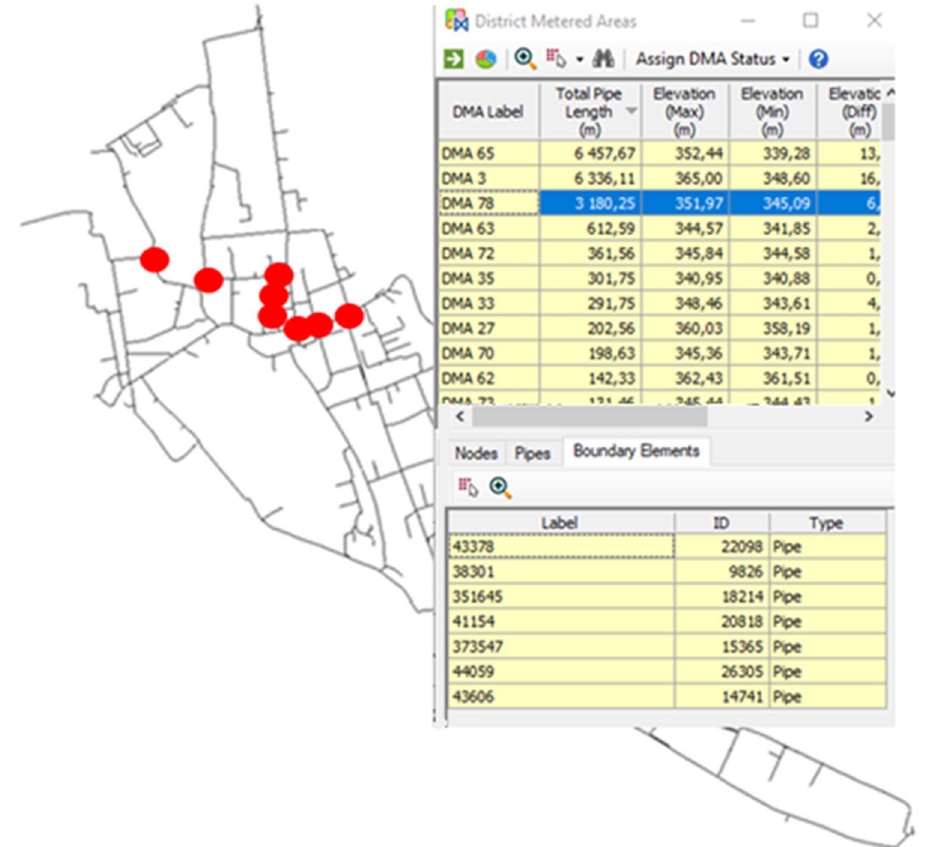
Fig. 7 Pipes constituting the boundary elements of DMA 02